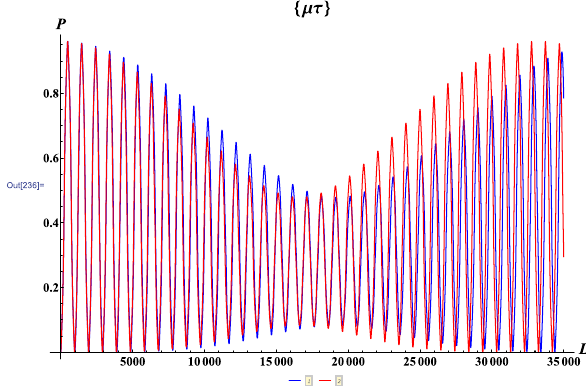
Fig. 2 Same analysis of Fig. 1, but for the oscillation probability from ν μ to ν τ